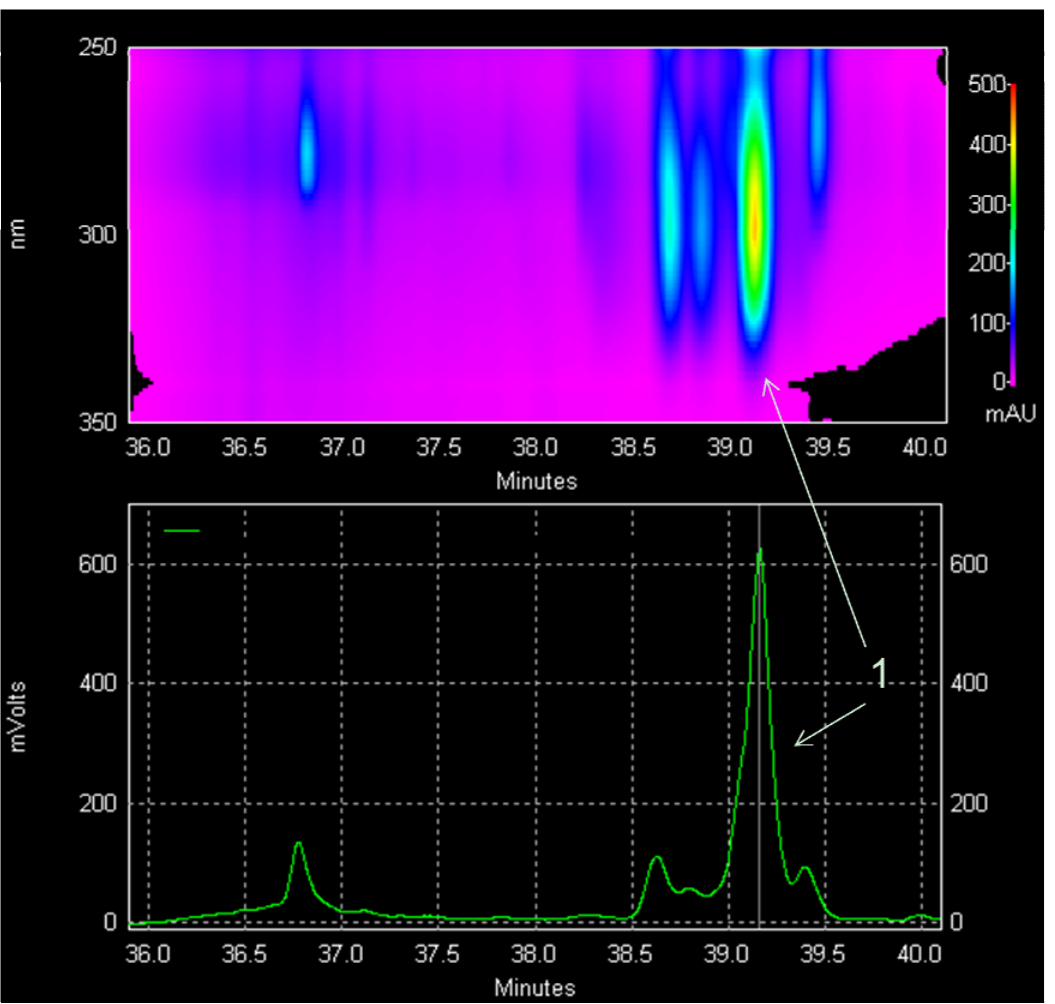
Figure 2. Diode array detector (upper panel) and evaporative light-scattering detector (lower panel) chromatograms from HPLC analysis of the fraction containing 1 . The extract is from a white-sand ecotype of P. subserratum growing near Jenaro Herrera, Peru. Based on retention times and UV absorbance, several forms of oxidized terpenes are likely present in the leaves, with 1 being the most abundant. Related forms were not isolated in sufficient quantity to permit structure